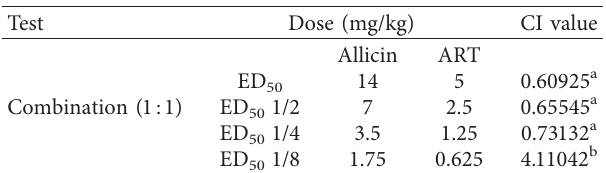
Figure 1: Effect of allicin and ART on PbANKA infection in mice. Groups of Balb/c mice were inoculated with 1 × 10 7 parasitized erythrocytes of PbANKA by IP injection and given orally with allicin (1, 10, 50, and 100 mg/kg) and ART (1, 5, 10, and 20 mg/kg) for 4 consecutive days. (a) Parasitemia and % inhibition were calculated, and (b) dose-response curves of the antimalarial effect of ( • ) allicin and ( ∗ ) ART were also investigated. UN, untreated control. ∗ P < 0 . 05, ∗∗ P < 0 . 01, and ∗∗∗ P < 0 . 001 compared to UN. Table 1: Combination index of combination between allicin and ART against PbANKA infection in